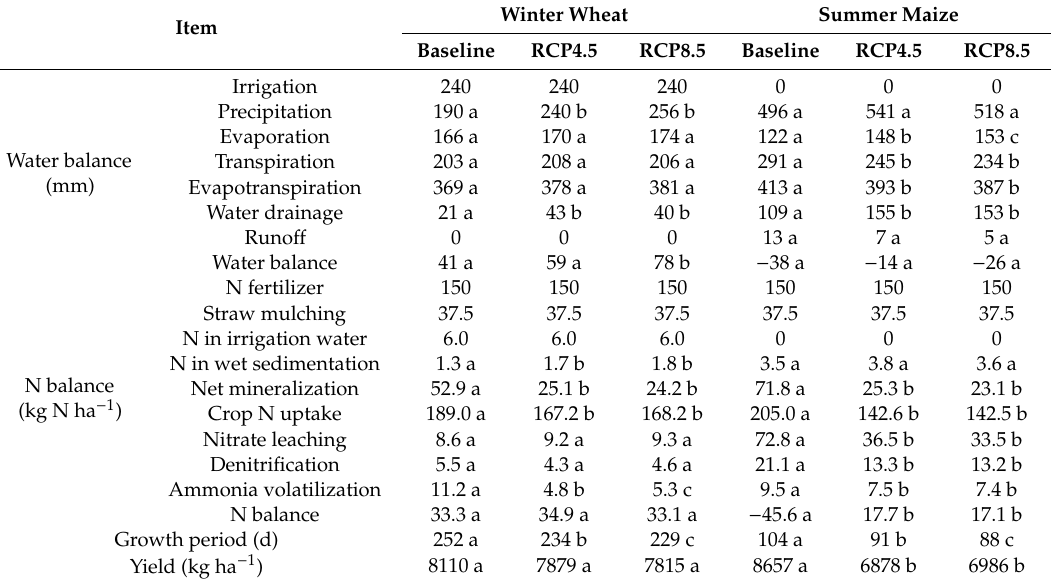
Table 2. Mean growth period, yield, water drainage, and nitrate leaching of winter wheat and summer maize under di ff erent climate